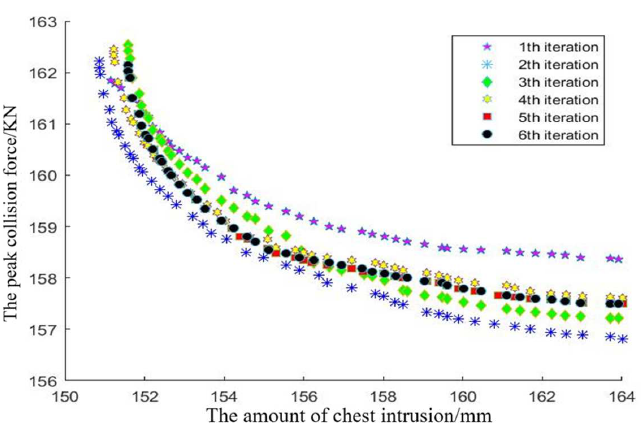
Figure 16. The iteration process of Pareto optimal front in finding solution of vehicle-side multi- objective crash worthiness using ARBF-MLPA method.